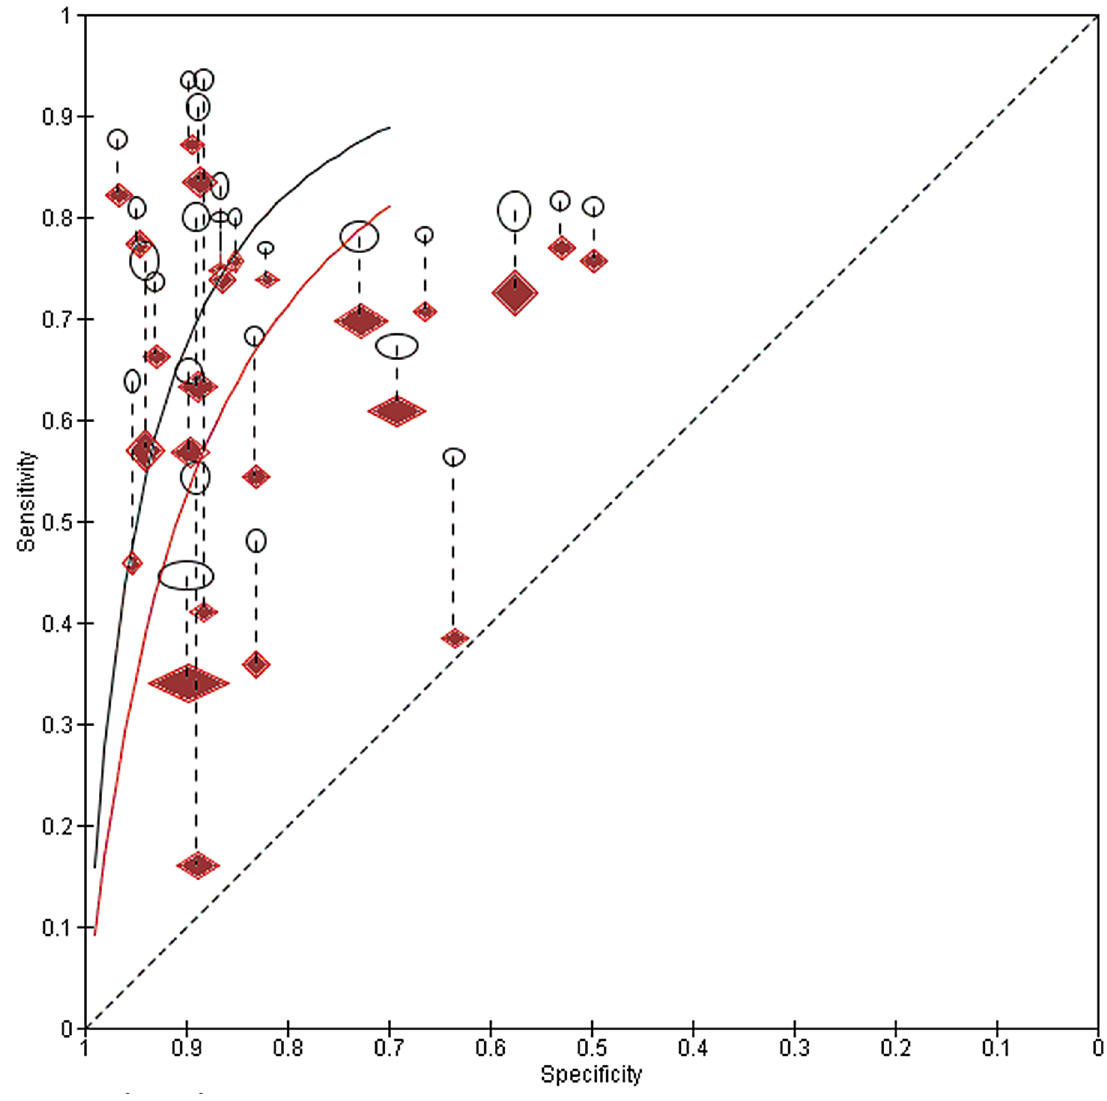
Figure 3. Receiver-operating characteristics (ROC) for dipstick performance in detection of S.haematobium egg-positive urine. Sensitivity/specificity of dipstick performance among sub-populations having light intensity infection (solid red diamonds), as compared to dipstick test performance reported for the total population in that study (open black ellipses). The symbol for each study is proportional to study size. Lines with long dashes link the data points for each study pair (N=25 pairs). The short-dashed diagonal line indicates the line of test non-discrimination (i.e., worst performance). The two smooth curves indicate the weighted summary ROC curves for each group—total population in black, and light- intensity subgroup in red.